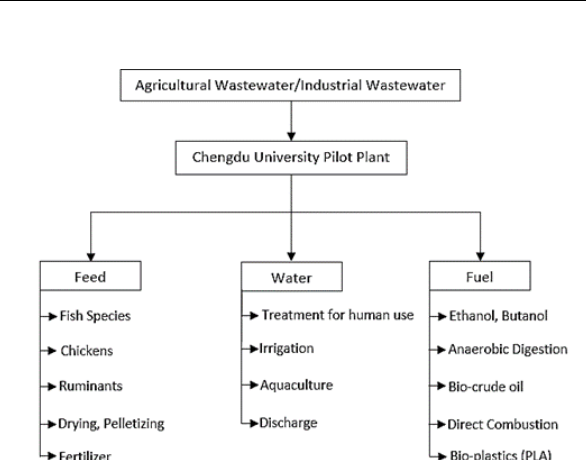
Figure 1. Flowchart of duckweed wastewater treatment and biomass application